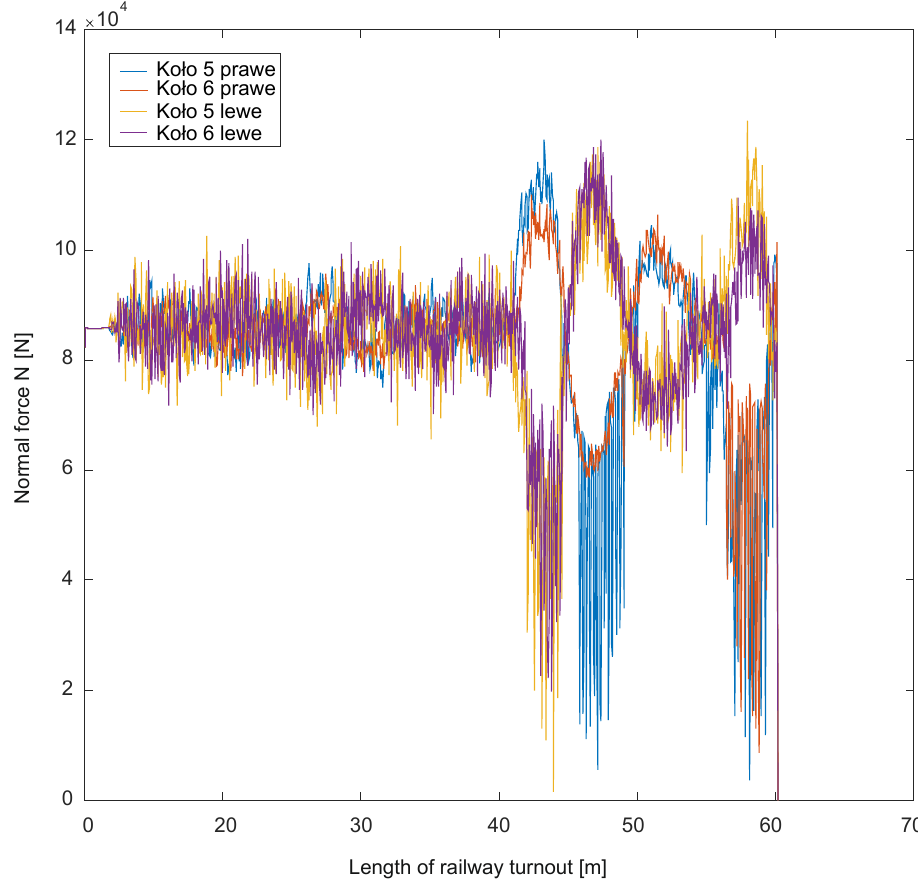
Figure 17. Normal force at 350 km/h on a straight track through a turnout. As seen in the figures, the magnitudes of vertical and normal forces increase as velocity increases. Significant changes occur if speeds increase above 100 km/h. For speeds above 250 km/h, the increase in vertical and normal forces occurs mainly within the cross member. The change in these quantities is due to the change in track stiffness. For a straight track without a turnout, the stiffness of the track is usually assumed constant. For a track with a turnout, the stiffness changes along the length as shown in Figure 4. These quantities increase up to 1.5 times the static load. Next, simulations were performed to determine the vertical and normal forces in straight-track traffic without a turnout. This was done for speeds from 150 km/h to 350 km/h and is shown in Figures 18–27. The value of the force due to the load per wheel is 8.1 × 10 4 N. The alternating loads fluctuate around this value. From the results presented, there are oscillations of these forces in the movement on the track without turnout, but there is no significant difference. There is an increase of about 1 × 10 4 N in the normal force. These forces are the basis for determining the contact surfaces and the amount of